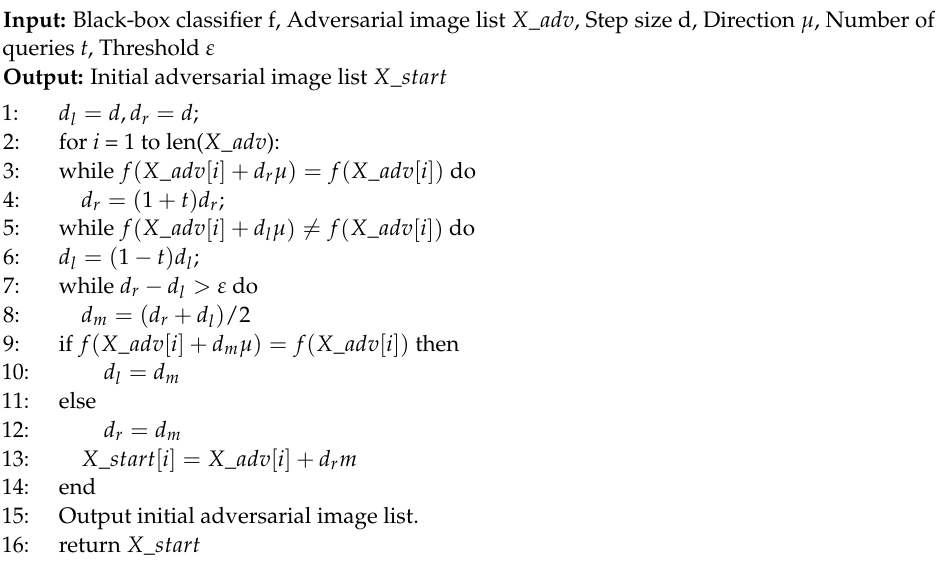
Algorithm 1. Improved algorithm of initial point selection